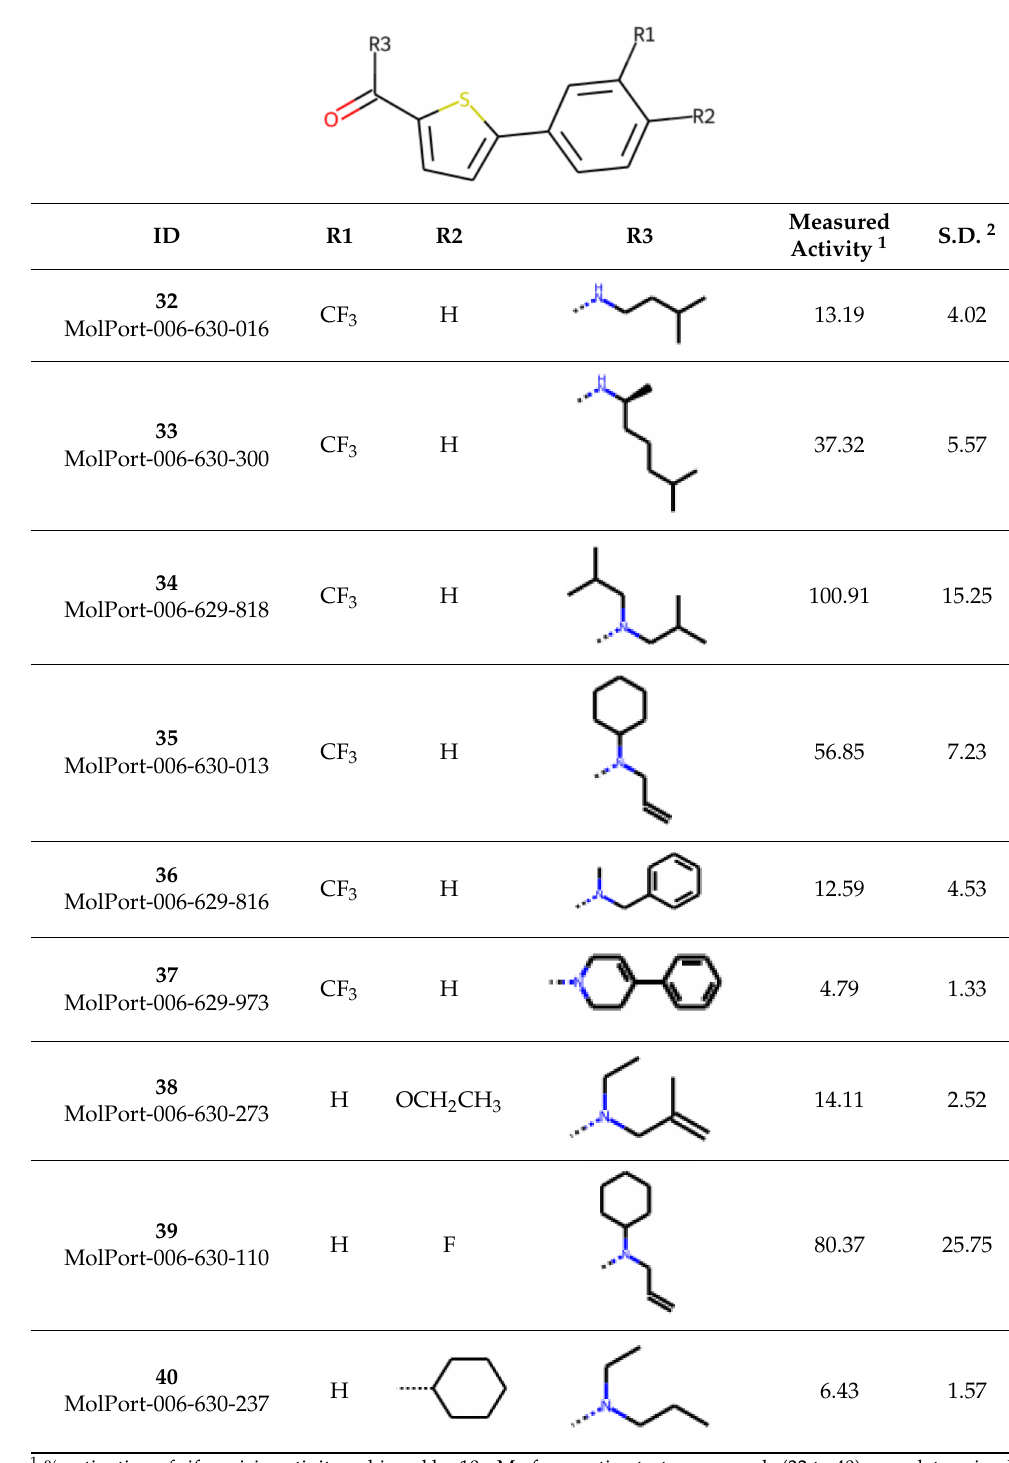
Table 5. Compounds tested in follow-up experiments related to 25